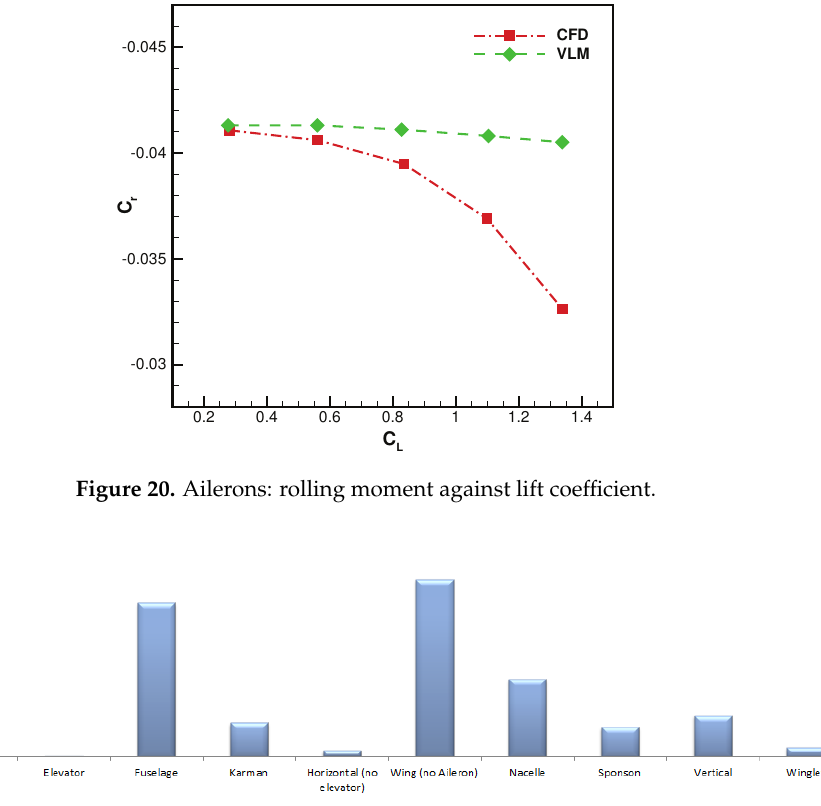
Figure 21. Drag breakdown for the whole aircraft with deflected ailerons.